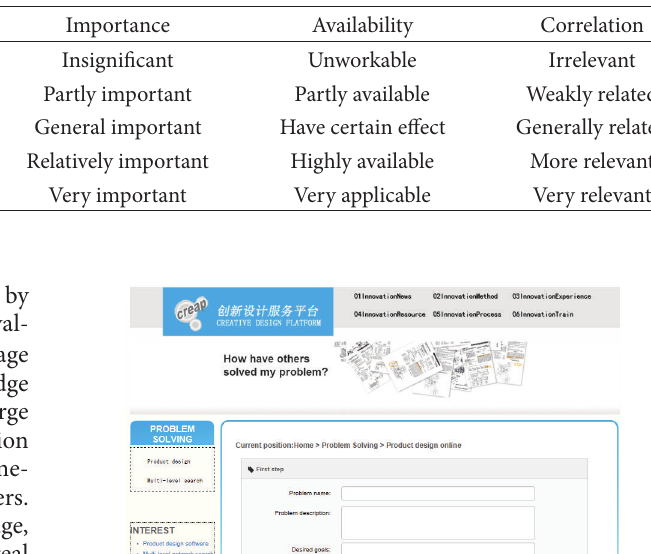
Table 3: Evaluation of the value of knowledge.